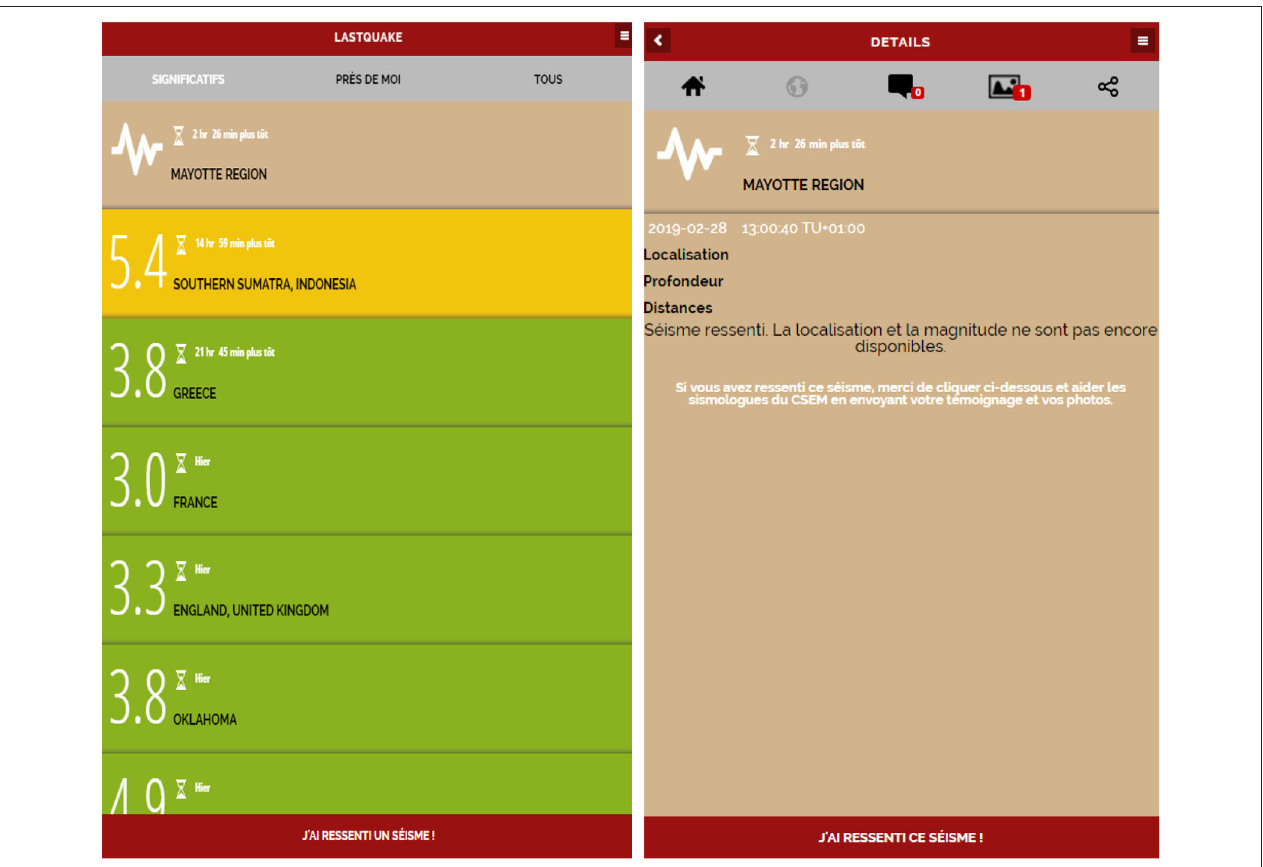
FIGURE 6 | A new type of event has been implemented in LastQuake (in brown). Though incomplete, the presence of some information has been found to be essential to users.